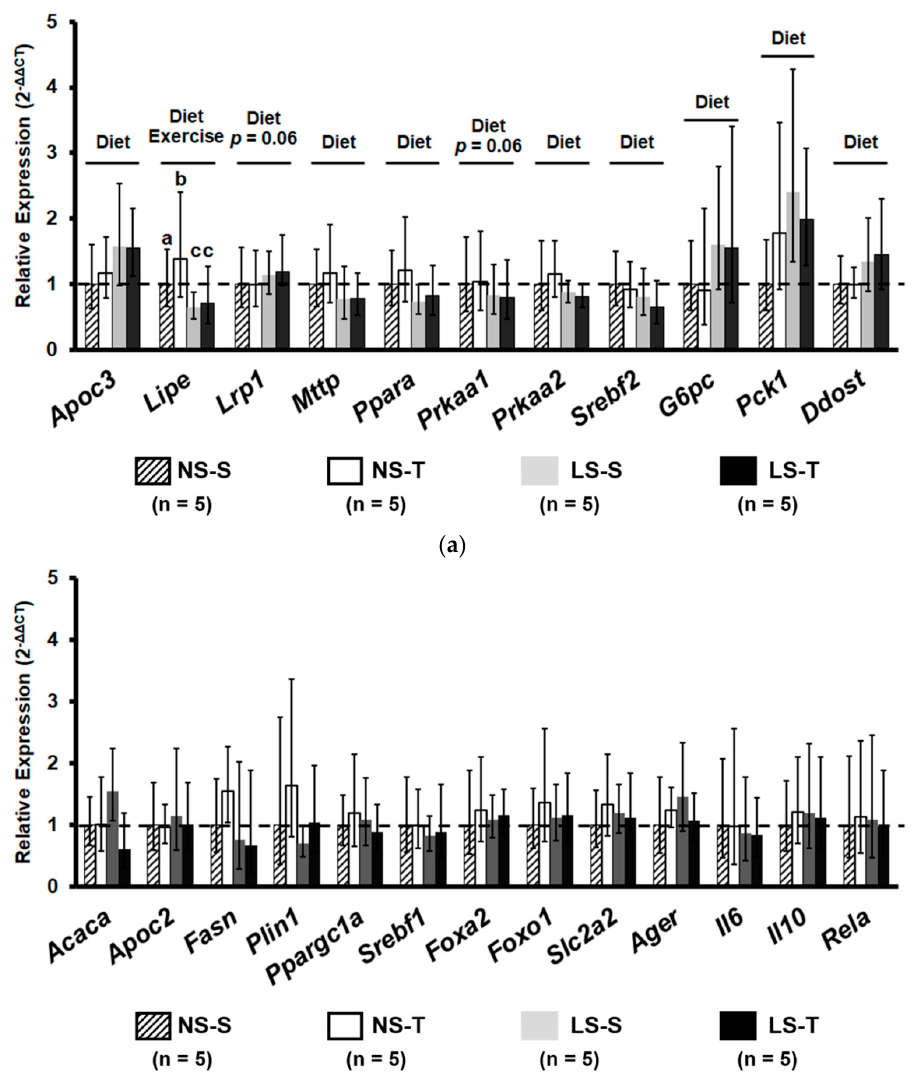
Figure 7. Relative gene expression (2 − ∆∆ CT ) of proteins related to lipid and carbohydrate metabolism and inflammation. Gene expression evaluated in liver homogenates. ( a ) Genes with statistical significance between intervention. ( b ) Genes without statistical difference. Data presented as mean ± range. Results compared by 2-way ANOVA (GLM; fixed factor: diet and exercise) with Tukey’s post hoc test. Distinct letters represent statistical differences among groups ( p < 0.05). “Diet” = p < 0.05 NS vs. LS. Exercise = p < 0.05 S vs. T. NS = normal-sodium diet; LS =